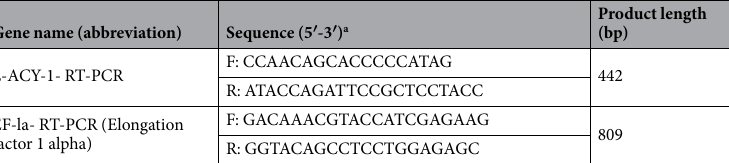
(Table 3; 20 pmol each). The common PCR cycling conditions included an initial denaturation at 95 °C for 5 min, followed by 30, 35, or 40 cycles of denaturation at 95 °C for 30 s, annealing at 55 °C ( L-ACY-1 ) or 60 °C ( EF-1a ) for 30 s and extension at 72 °C for 1 min, and a final extension at 72 °C for 5 min. The resultant RT-PCR products (20 with ImageJ. qPCRs of H. armigera and H. assulta L-ACY-1, RPL-13, RPL-32 and β - Tubulin were individually performed